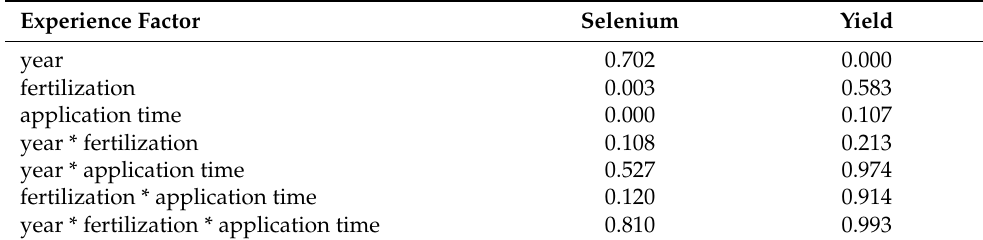
Table 3. The influence of experimental factors on the selenium content in grain and the yield.